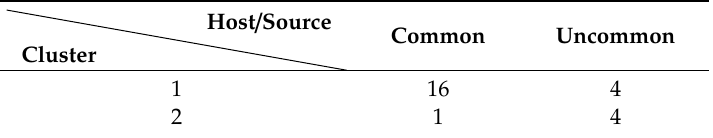
Figure 5. SV persistence times and mutation counts of isolates. K-means clustering grouped isolates with SVs into ( a ) two groups of amplifications, ( b ) six groups of translocations, and ( c ) two groups of deletions. Each point represents an isolate with their corresponding persistence time (scaled by branch length) vs mutation count. Numbers of clusters were determined by the Silhouette Method. Significant differences in mutation counts ( d ) and persistence times ( e ) were examined for the two clusters in the K-means analysis of amplifications. The two clusters of amplifications represent isolates with higher persistence times (1.1%) and lower mutation counts (0.2, Cluster 1), and isolates with lower persistence times (0.7%) and higher mutation counts (24.1, Cluster 2). Table 1. Fisher’s Exact test comparing host association to SV persistence times and counts. Columns represent common and uncommon hosts ( U. californica , N. densiflorus ) and sources (twig, leaf, bark, stream water) of P. ramorum . Isolates with high persistence times and low mutation counts are in Cluster 1; isolates with low persistence times and high mutation counts are in Cluster 2. Odds ratio = 13.8 and p -value = 0.023. Host / Source Common Uncommon Cluster